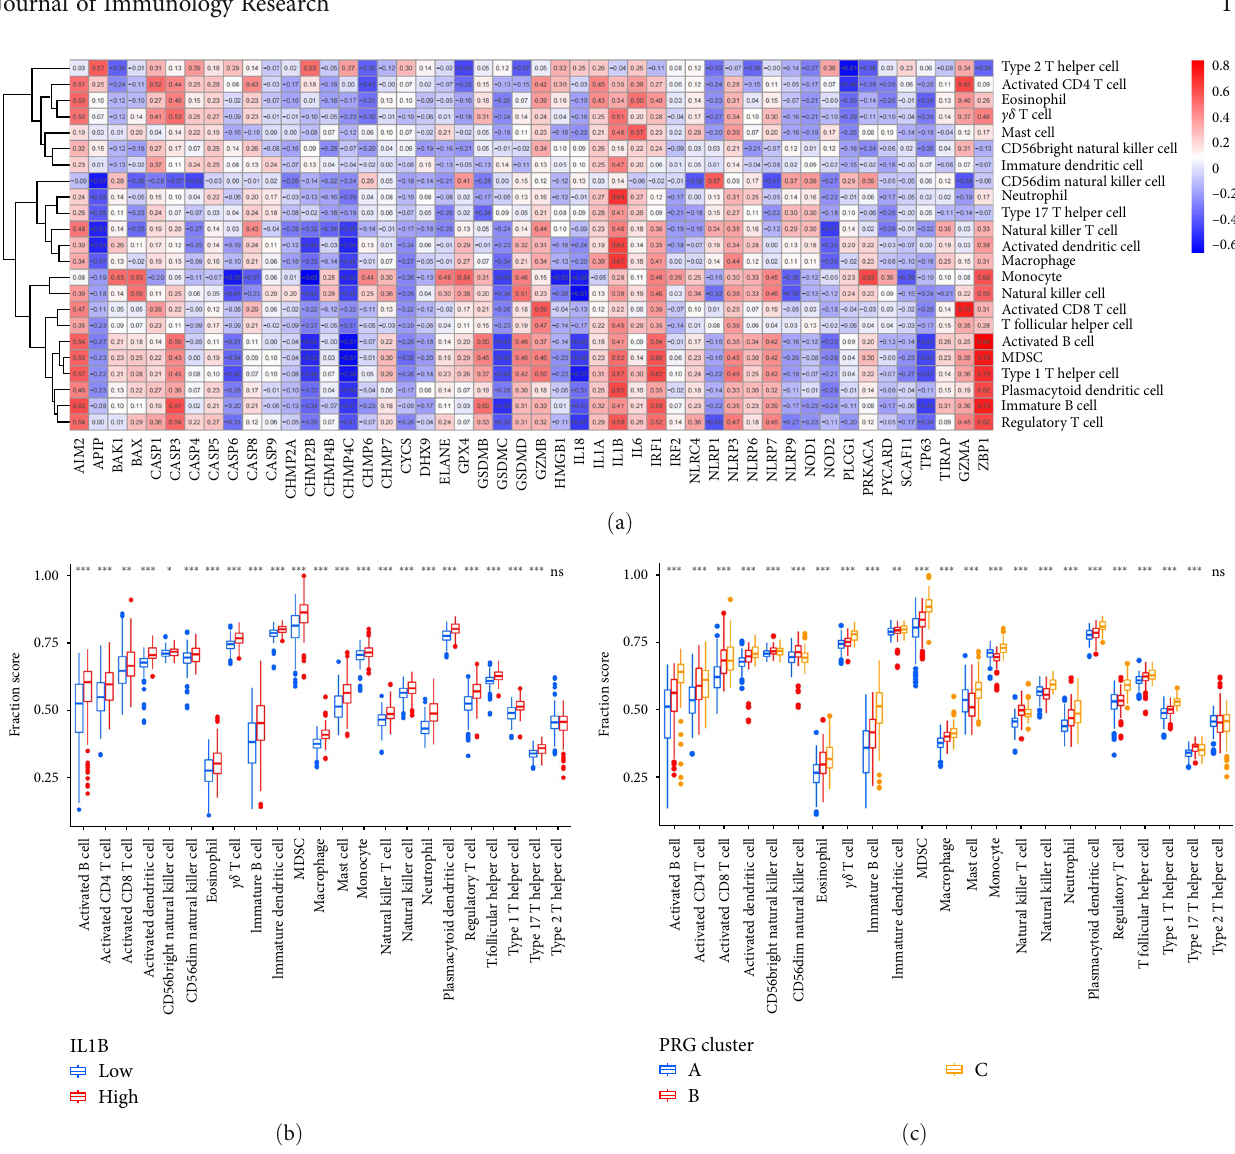
F IGURE 7: Estimation of immune cell in fi ltration. (a) Relevance of in fi ltrating immune cells to 48 different PRGs; (b) Differential immune cells in fi ltration between high and low IL-1 β level groups. (c) The abundance differences of immune cell in fi ltration among three PRG patterns. ∗ p < 0 : 05, ∗∗ p < 0 : 01, and ∗∗∗ p < 0 : 001. PRG, pyroptosis-related